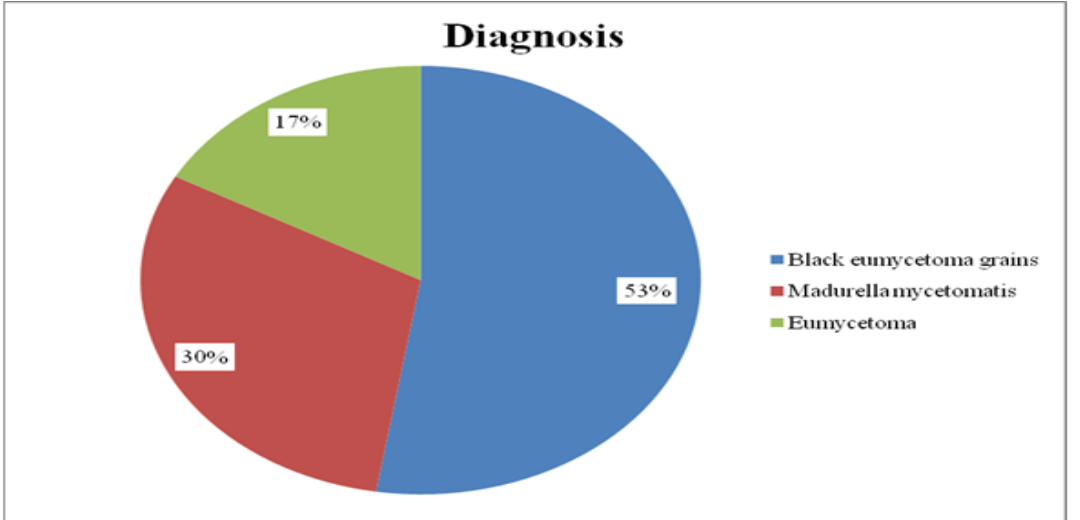
Figure 3. Distribution of study samples according to